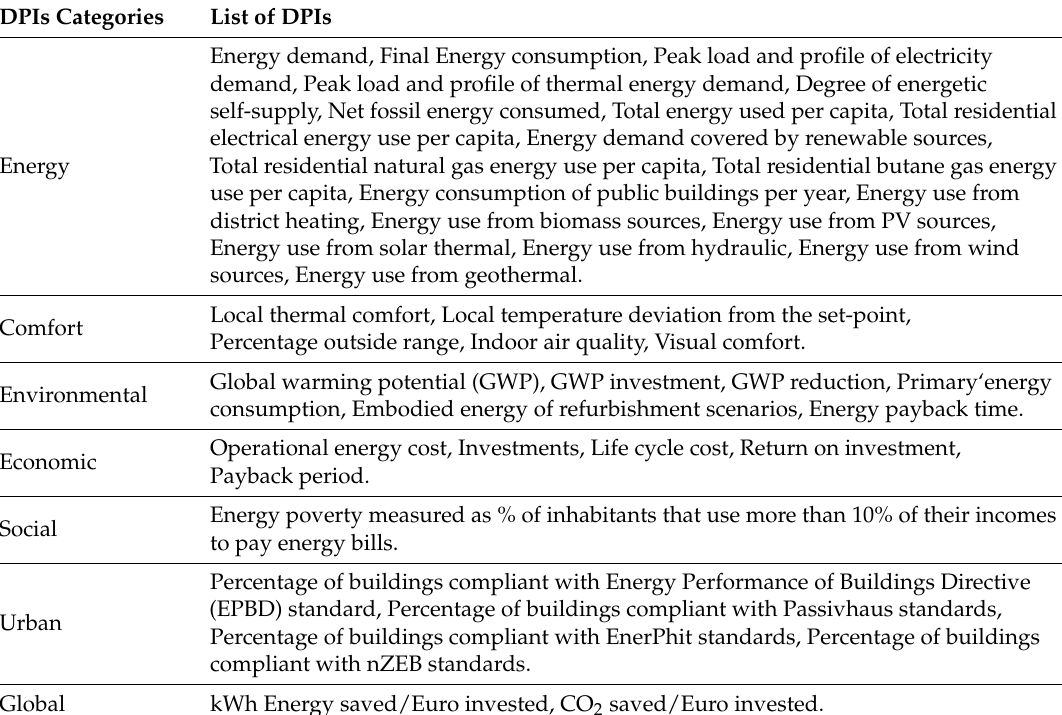
Table 1. District Performance Indicators defined in the OptEEmAL